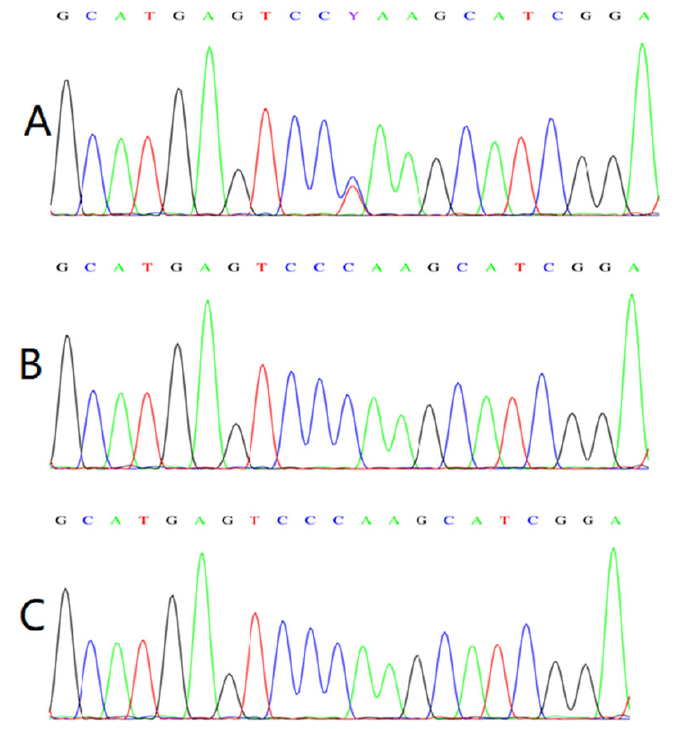
Figure 3. ( A ): He had a novel heterozygous nonsense variant of c.1957C > T (p.Q653*). ( B , C ): Variant analysis of his father and mother showed no variants in the TRPS1 gene.